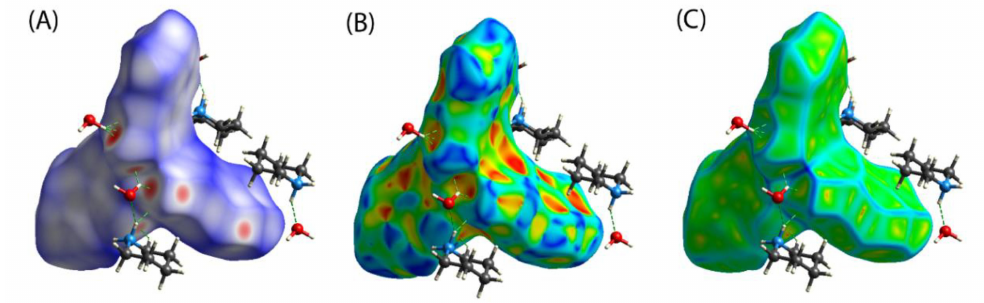
Figure 2. Hirshfeld surfaces mapped with d norm ( A ), shape index ( B ) and curvedness ( C ) for